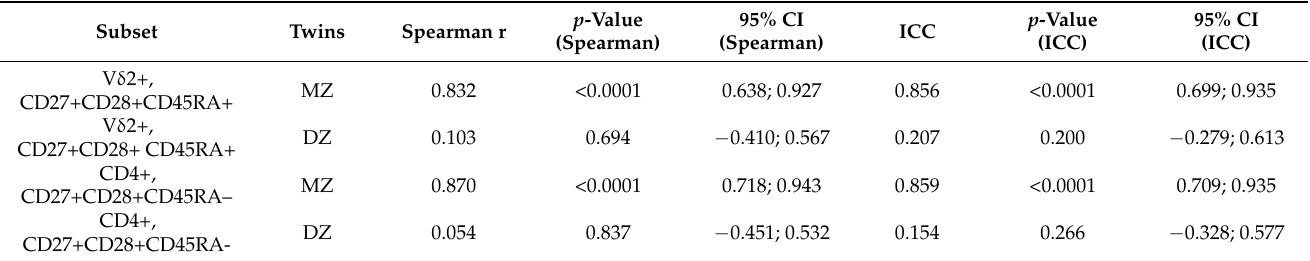
Table 2. Spearman correlation and intraclass correlation in MZ and DZ twins.